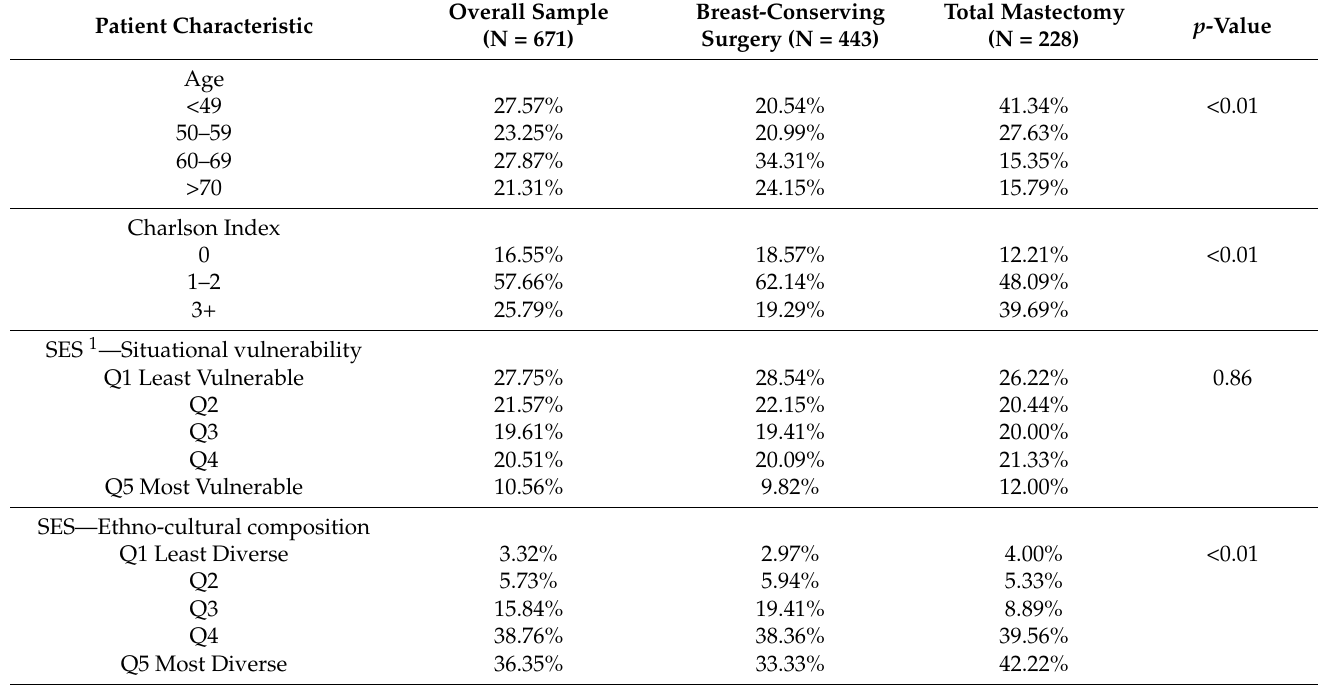
Table 1. Summary of participant’s age category, overall and stratified by partial mastectomy and total